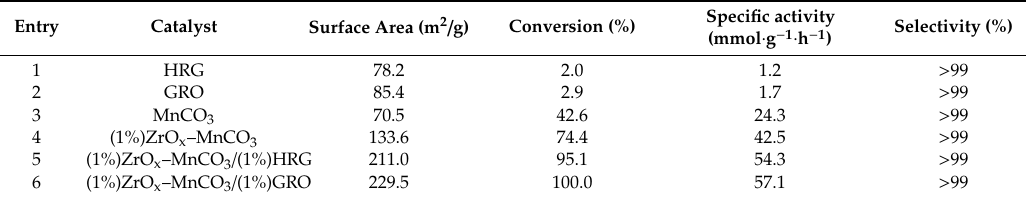
Table 2. Selective oxidation of BzOH catalyzed by various